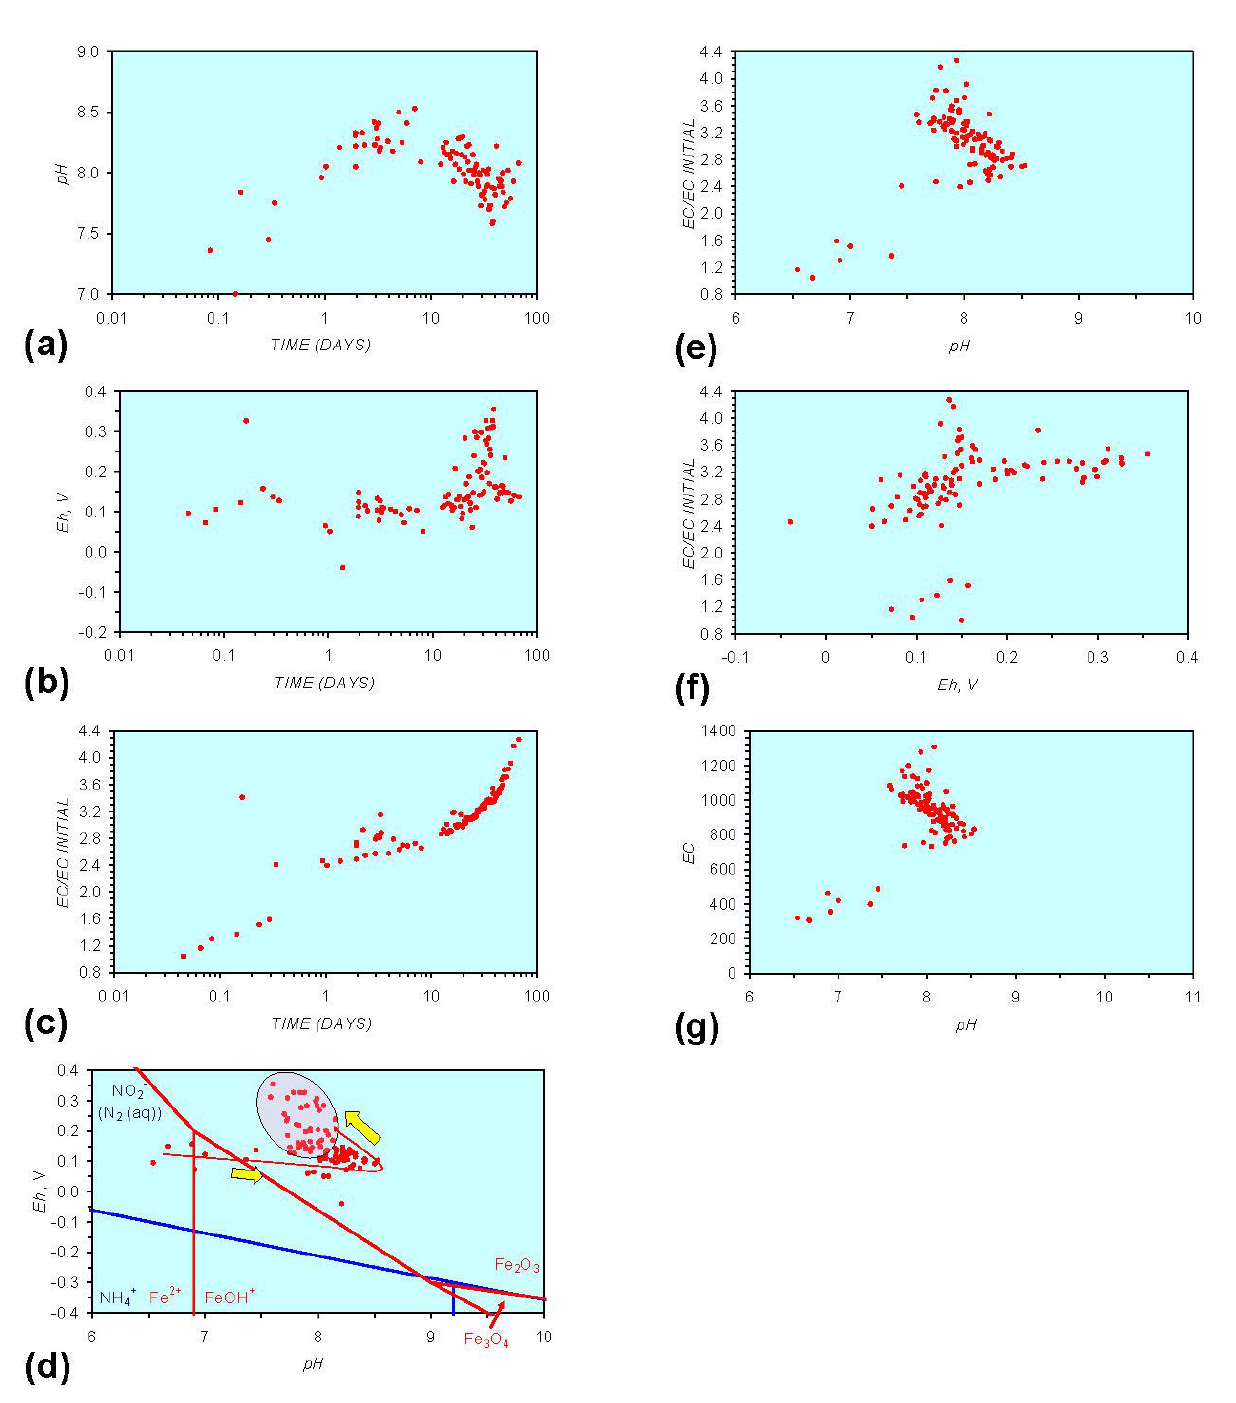
Figure A9. MR9: Ca-montmorillonite, fresh water. (a) pH vs. Time; (b) Eh vs. time; (c) EC/EC Initial vs. time; (d) Eh vs. pH (SRE ringed); (e) pH vs. EC/EC Initial; (f) Eh vs. EC/EC Initial; (g) pH vs. E(C) Arrows indicate decreasing SV and increasing